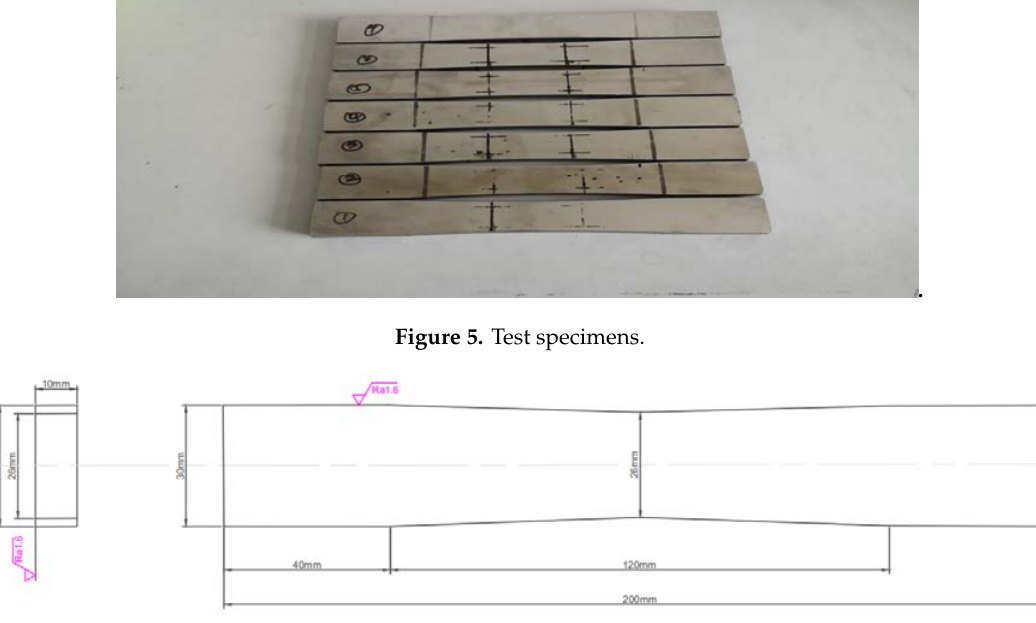
Figure 6. Dimensions of the test specimens.